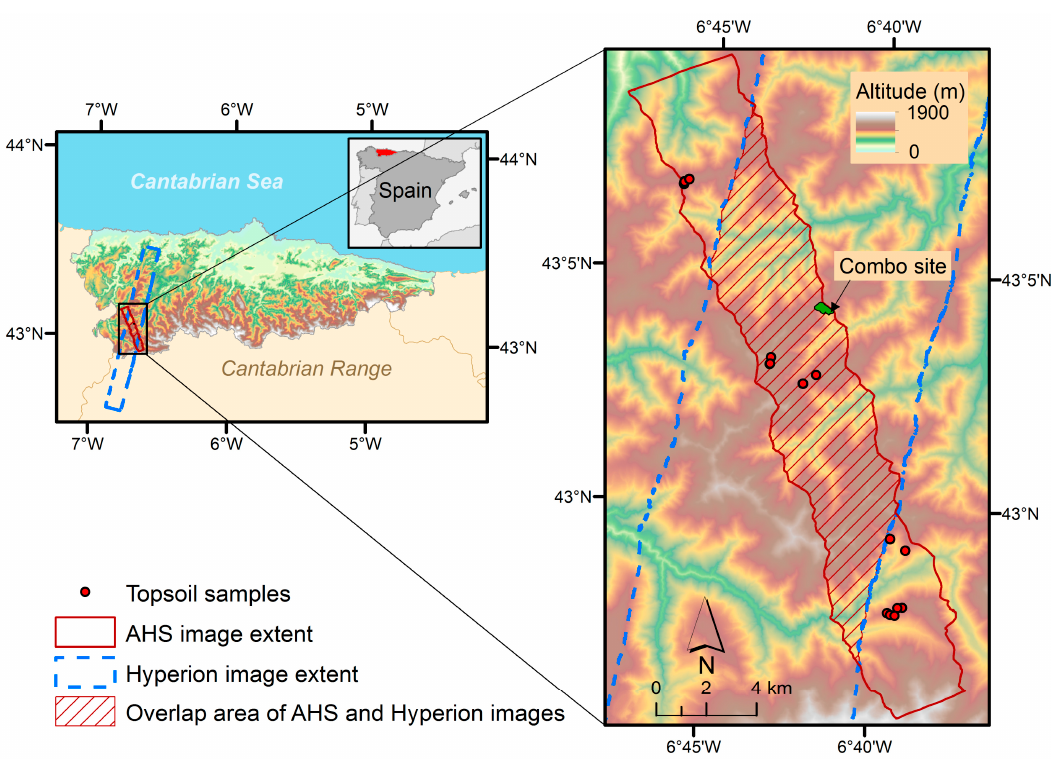
Figure 1. Location of the study area in NW Spain and extent of the Airborne Hyperspectral Scanner (AHS) and Hyperion images.